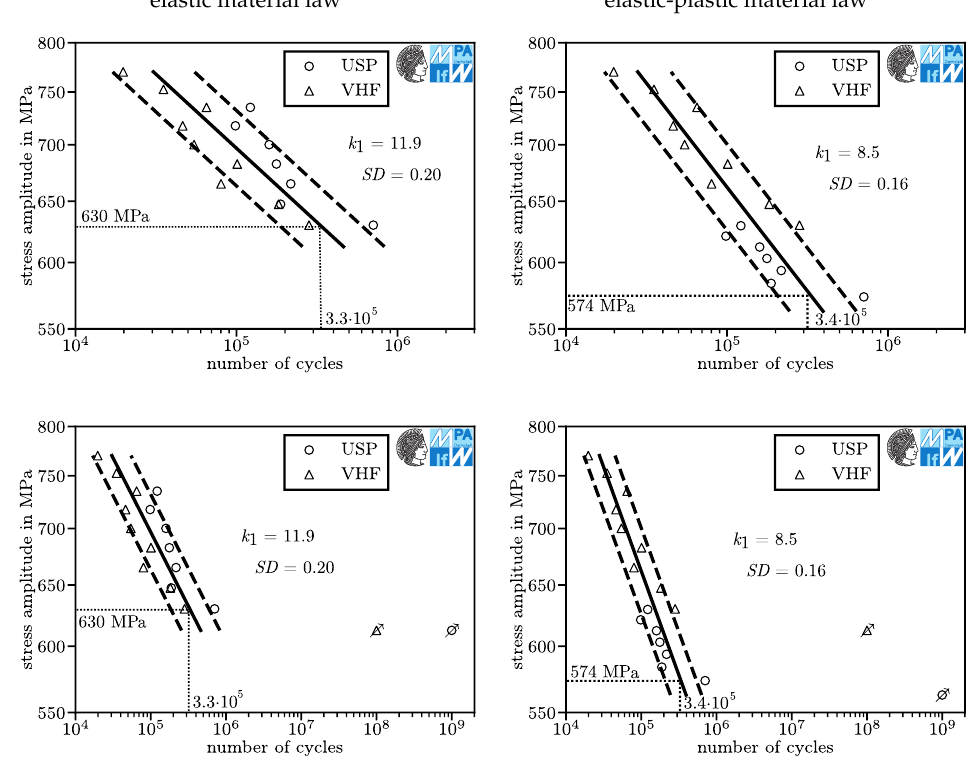
Figure 9. Fatigue behavior of 50CrMo4 in laboratory air; 919MPa ultimate tensile strength; K t = 1.75; Curves of 10, 50 and 90% probability of survival; run-outs are marked with an arrow; left side: before correction; right side: after correction; top: only HCF region; bottom: including VHCF